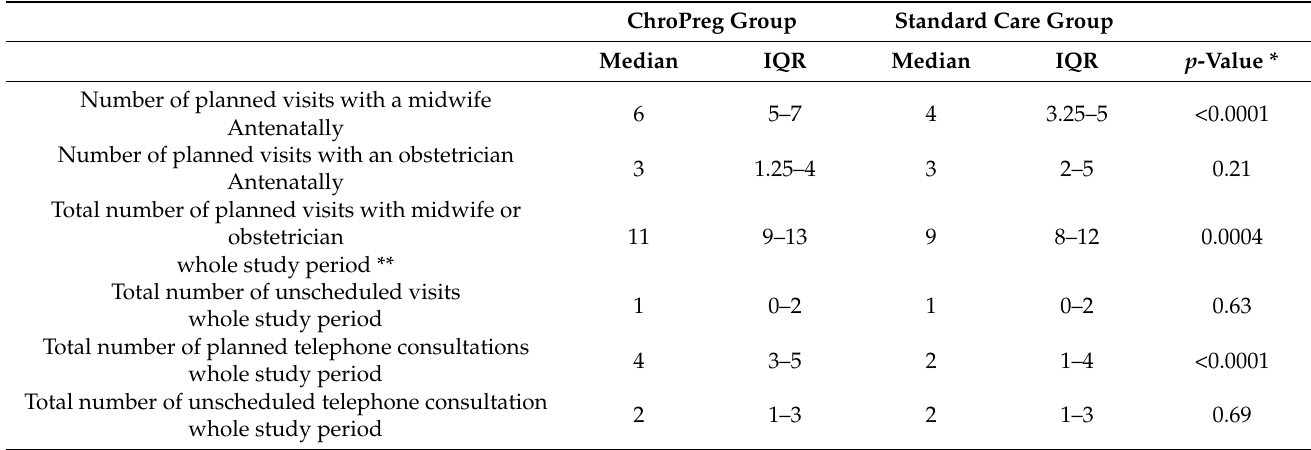
Table 6. Health utilization for the intention-to-treat population according to